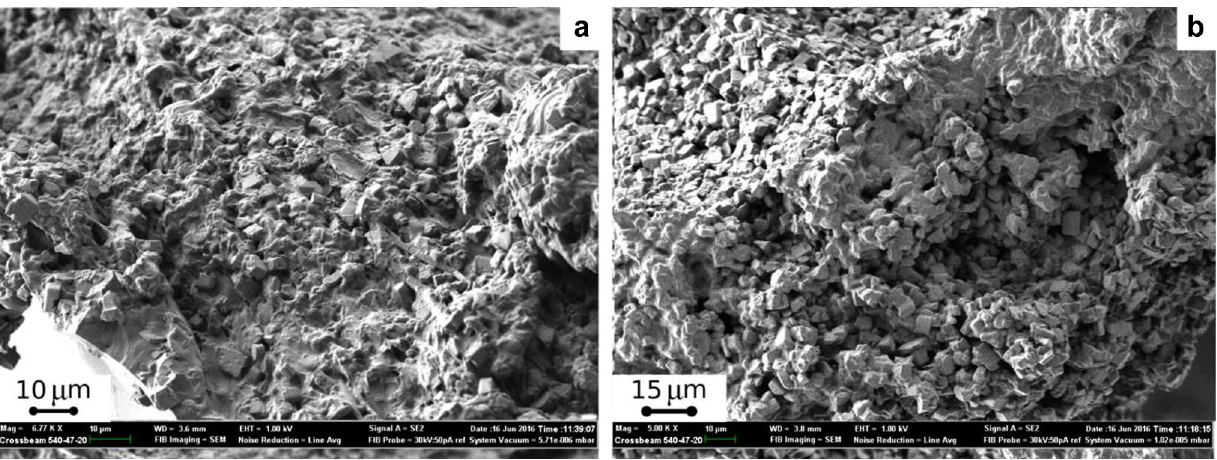
Fig. 2 SEM image of cellular wall in ZF-50 ( a ) and ZF-70 ( b ) foam samples